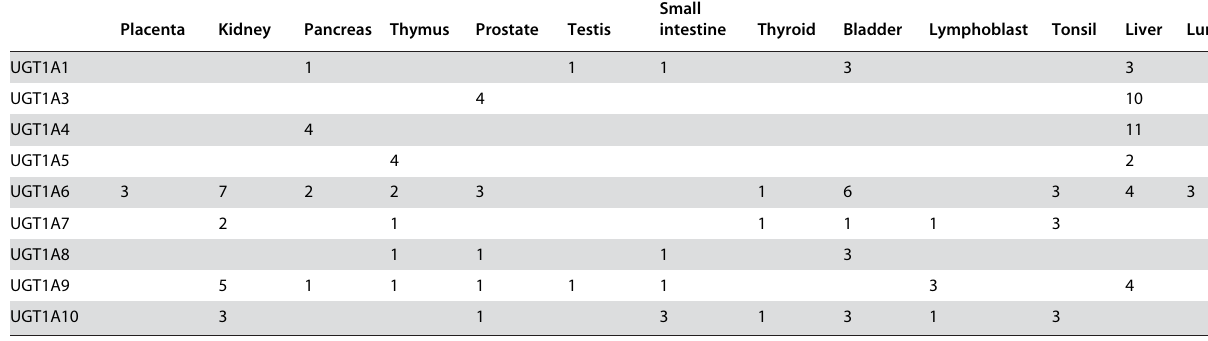
Table 1. Relative expression levels of UGT1A isoforms among multiple human tissue samples. .. ... .... ... ... .... ... ... .... ... ... .... ... ... .... ... ... .... ... ... .... ... ... .... ... ... .... ... ... .... ... ... .... ... ... .... ... ... .... ... ... .... ... ... .